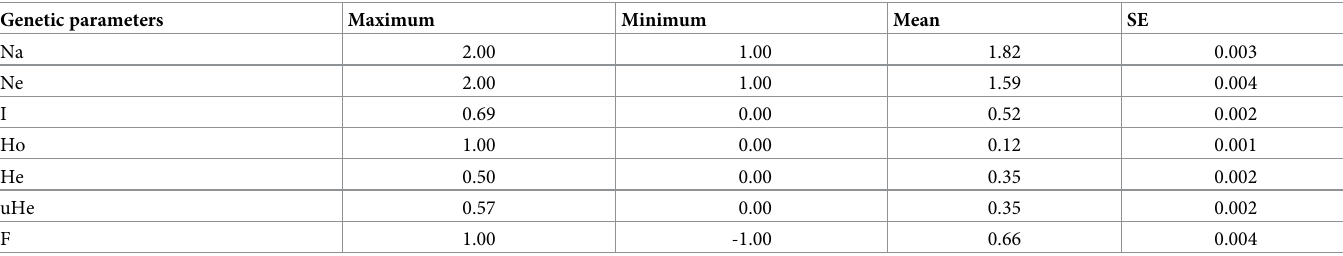
SE = Standard error, Ne = no. of effective alleles I = Shannon’s information index = 1 � Sum (pi � Ln (pi)), Na = no. of alleles, Ne = Number of effective alleles, Ho = observed heterozygosity, He = expected heterozygosity, uHe = Unbiased heterozygosity and F = fixation